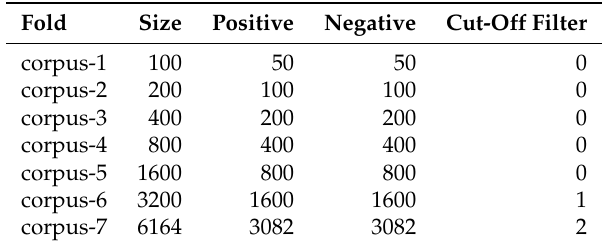
Table 2. Details of the corpora